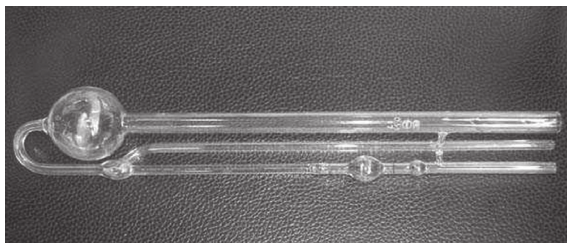
Figure 3: Capillary